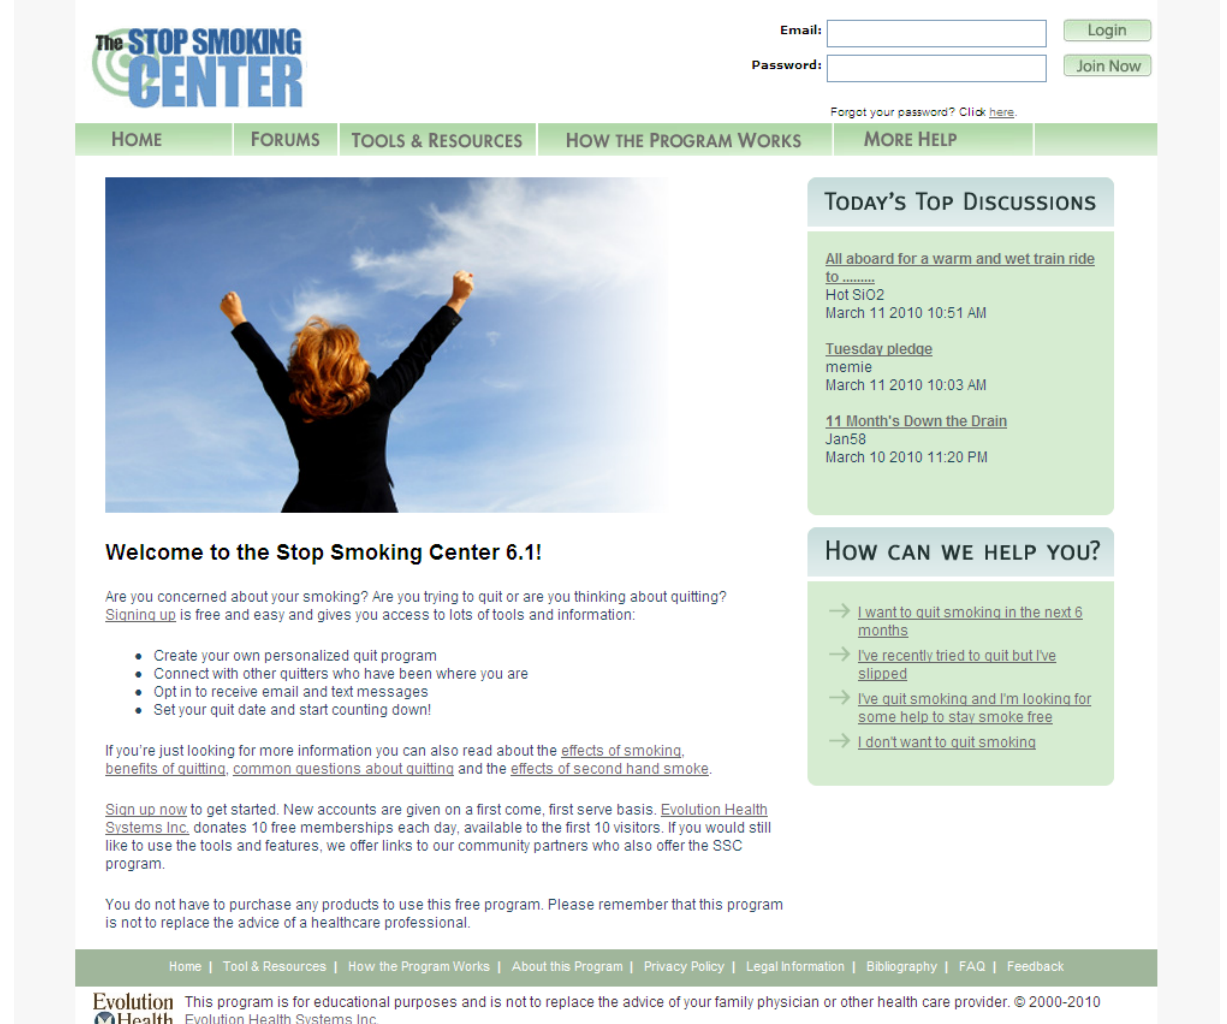
Figure 1. Screenshot of StopSmokingCenter.net 6.1 home